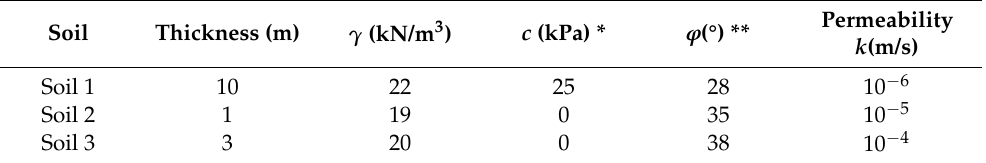
Table 1. Geotechnical properties of levee